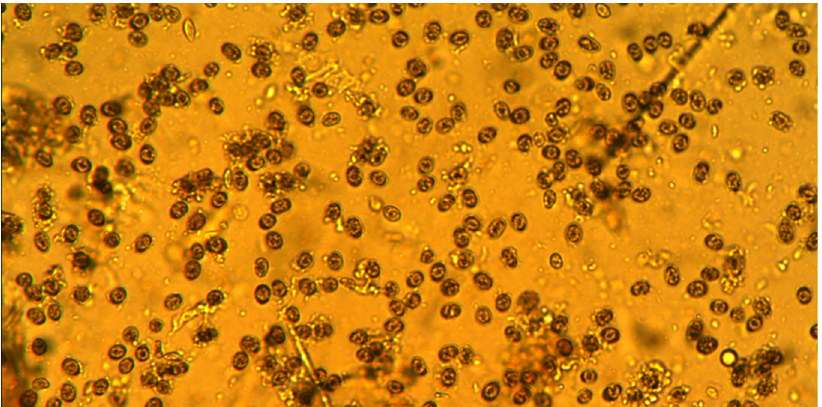
Fig 1. Eimeria spp. oocysts observed in intestinal (fecal) samples in one broiler chicken on Farm K in San Cristobal.